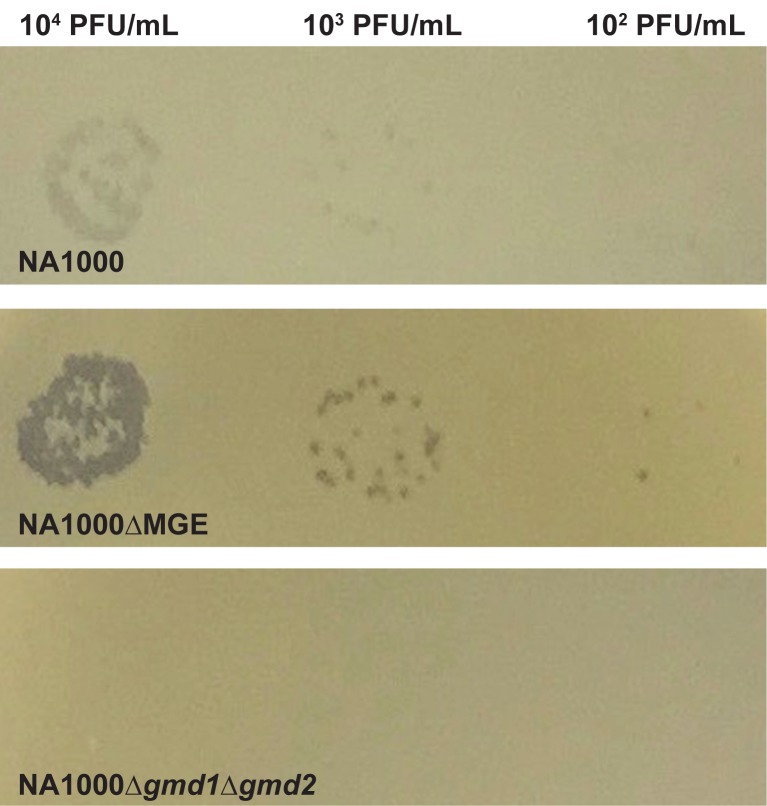
Gmd activity is required for maintenance of S-layer dependent phage CR30 susceptibility.Both NA1000 (EPS+, top) and NA1000ΔMGE (EPS-, middle) support plaque formation when challenged with phage CR30 lysates (102–104 pfu/mL). Note that NA1000ΔMGE is about 10-fold more sensitive to CR30 infection under these conditions, consistent with previous findings [16,24]. In contrast, NA1000Δgmd1Δgmd2 (EPS-, bottom) does not support phage CR30 plaque formation; a result that is consistent with the hypothesis that this strain sheds the S-layer because it is unable to synthesize N-acetylperosamine and assemble normal LPS O-antigen (Fig 1) [30,31].